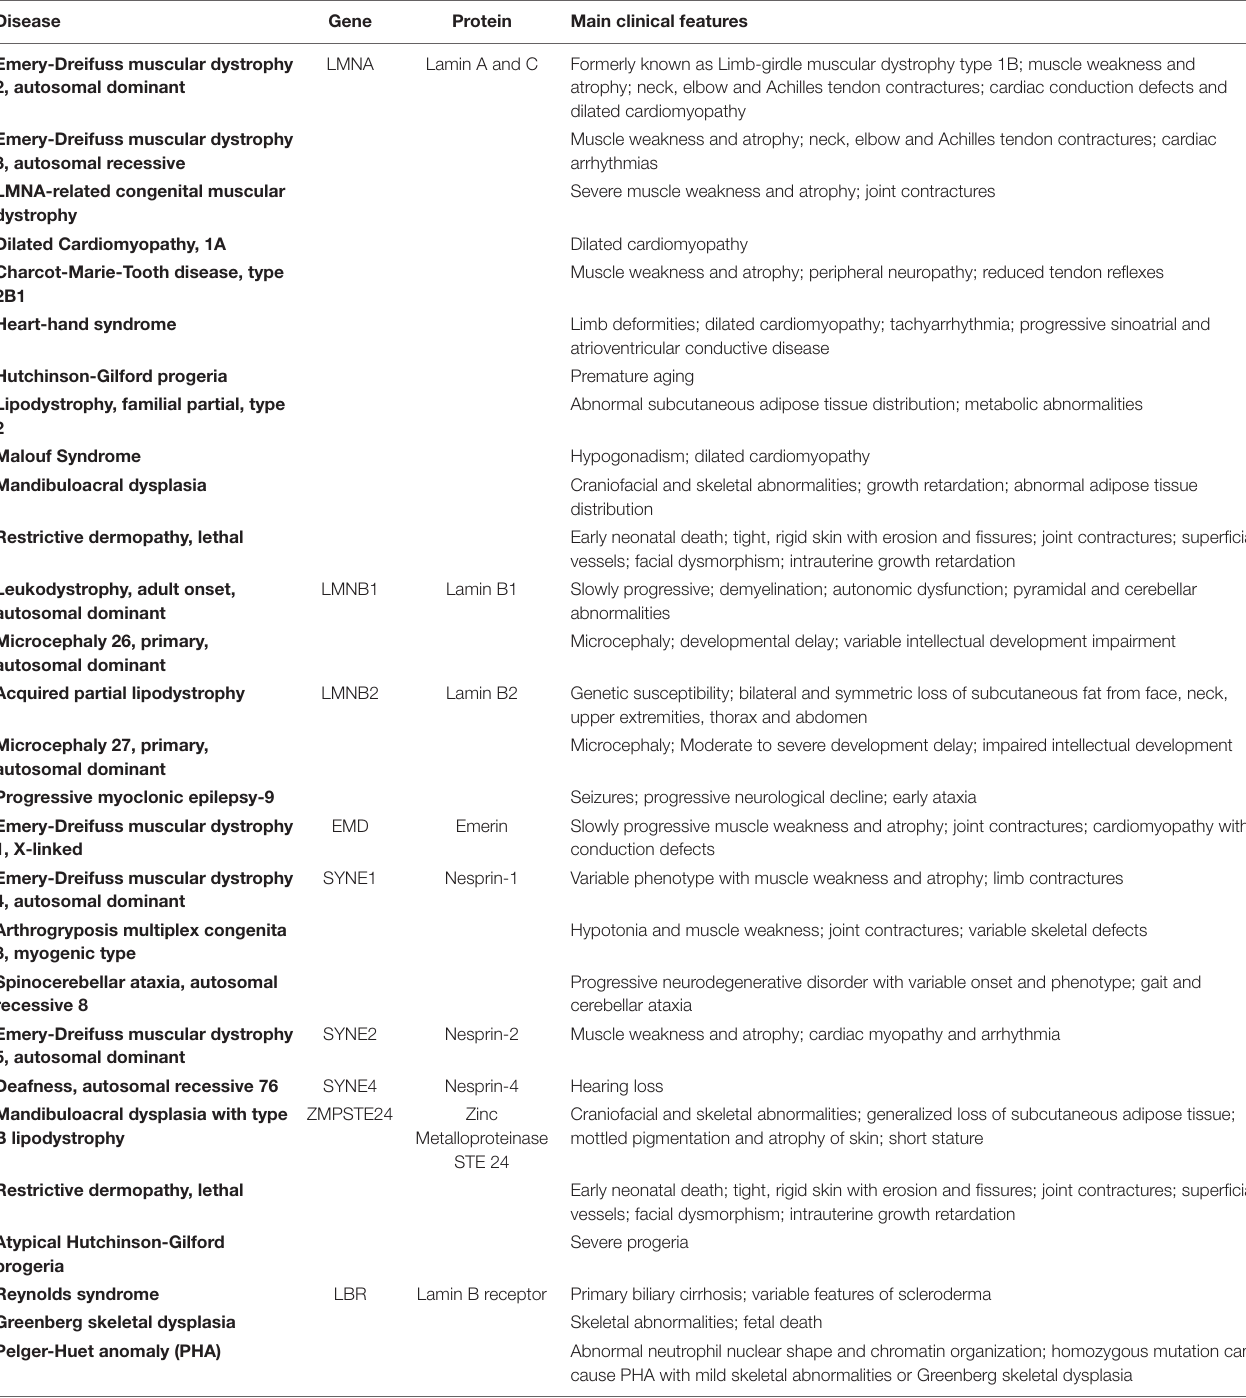
TABLE 1 | Diseases associated with mutations in genes for lamin proteins and proteins associated with the LINC